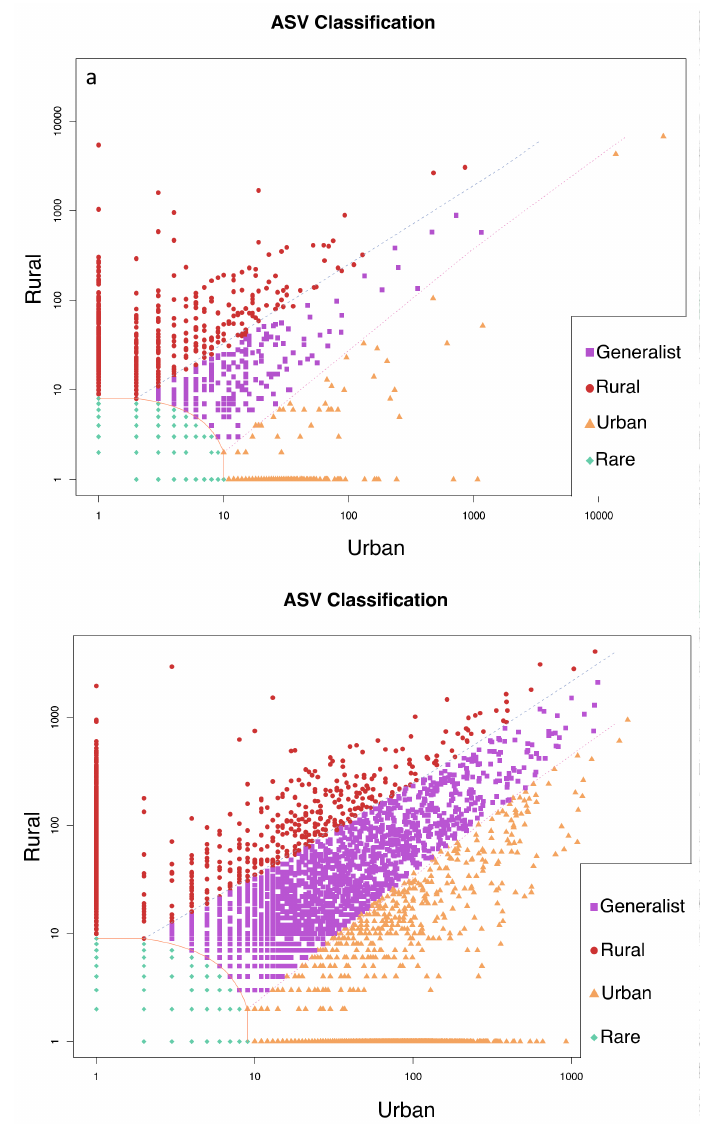
Figure 5. CLAM test results showing the classification of ASVs as habitat specialists or generalists based on relative abundance of species at each site for Buenos Aires ( a ) and Washington D.C. ( b ). ASVs were divided into four categories: urban specialists (Urban), rural specialists (Rural), generalists with no habitat preference, and too rare to classify (Rare). Note: some points are stacked so that specific values for each category can be found in the